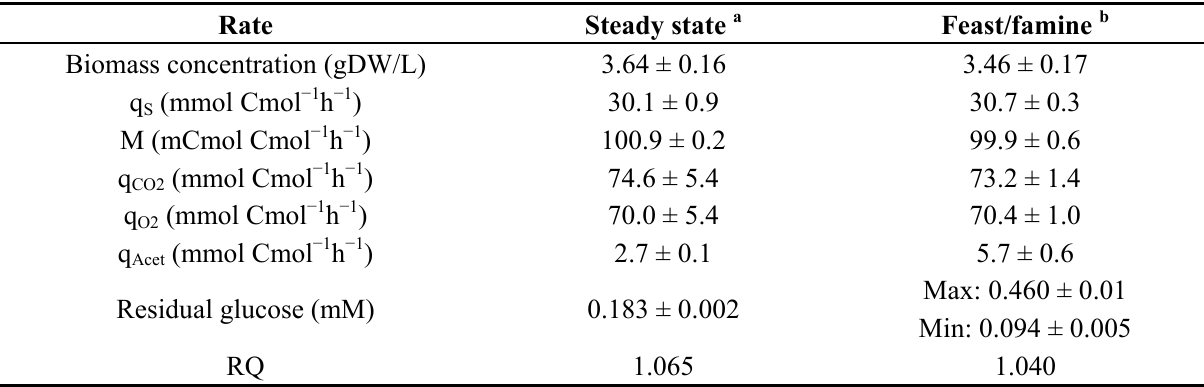
Table 1. Reconciled rates for both steady-state and feast/famine